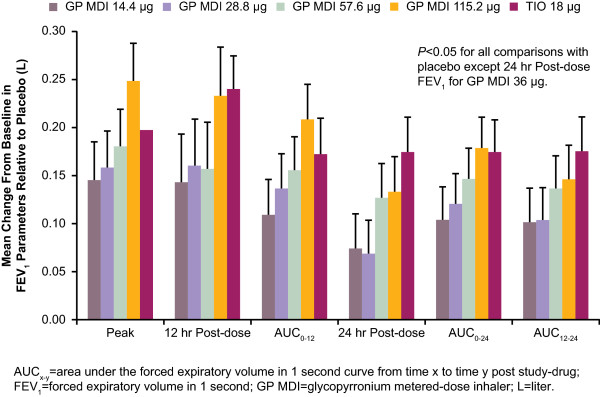
Adjusted Mean (±standard error) change from baseline in FEV
1
parameters relative to placebo; provides a concise depiction of the mean change from baseline in peak FEV
1
, 12-hour FEV
1
, FEV
1
AUC
0–12
, 24 hour FEV
1
, FEV
1
AUC
0–24
, FEV
1
AUC
12–24
.